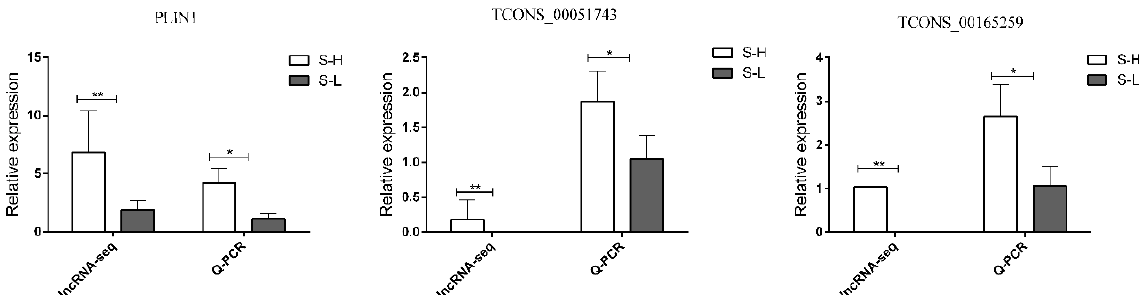
Figure 6. Verification of sequencing data by RT-qPCR. Comparisons of relative expression levels for 1 DEGs and 2 DELs. Comparisons of relative FPKM in the left; comparisons of relative expression levels in the right. * means p < 0.05, ** means p < 0.01. Since the FPKM values of TCONS_00051743 and TCONS_00165259 in the S-L group are 0, so there are no columns in the bar chart.